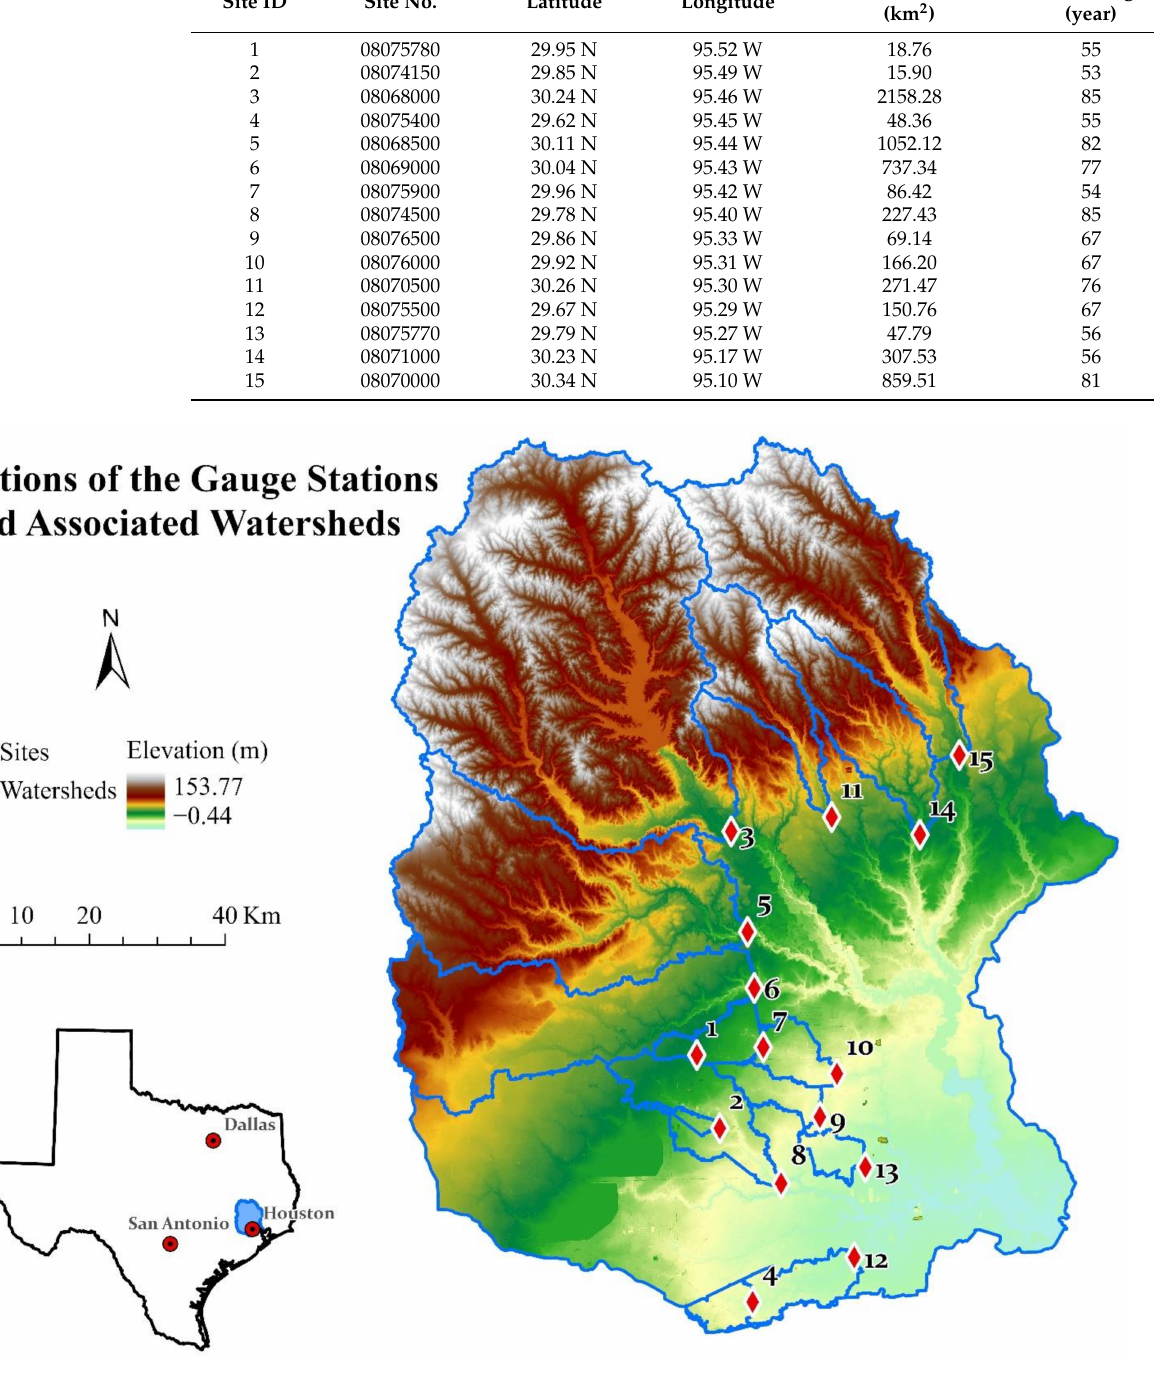
Figure 2. Study area, locations of the 15 gauge stations, and associated watersheds. The annual peak discharge time series data were obtained from the USGS National Water Information System. Among the 95 sites in the San Jacinto accounting unit, there are 76 sites with records longer than 5 years. Using the 1 / 3 arc-second seamless DEM dataset of the 3D Elevation Program, we generated 76 watersheds from the gauge stations. 29